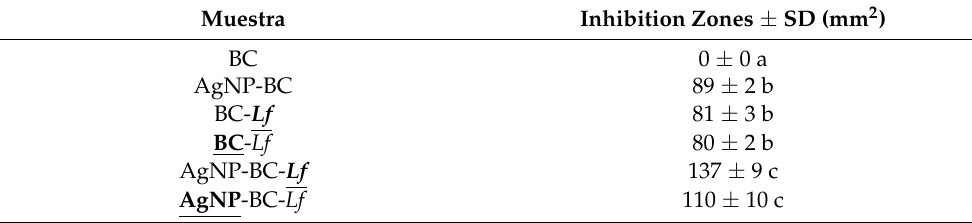
Table 1. Area of the inhibition zones around the cellulosic samples in the antimicrobial assays shown in Figure 4. Results are shown as means of three replicates ± standard deviation (SD). Statistical analysis was carried out by the one-way ANOVA (Bonferroni’s method). Letters indicate significant differences ( p < 0.05) between samples. The BC side in direct contact with agar is indicated in bold and underline